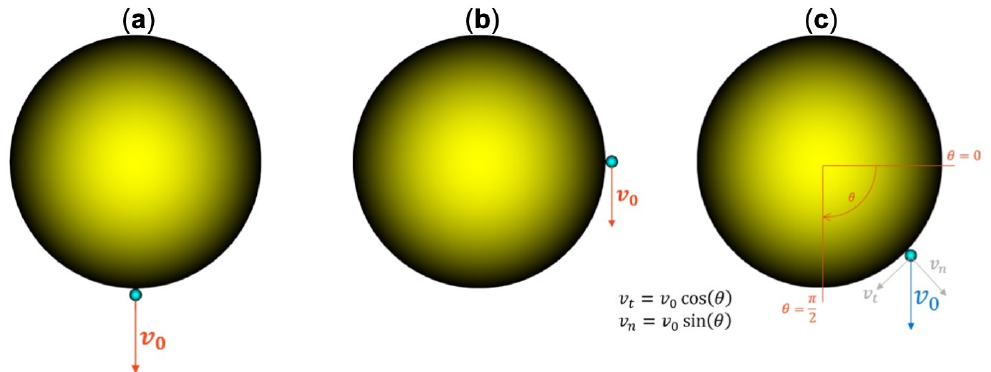
Figure 6. ( a ) API particle in south pole position, ( b ) API particle in equatorial position, ( c ) API particle attached in a generic position in the south